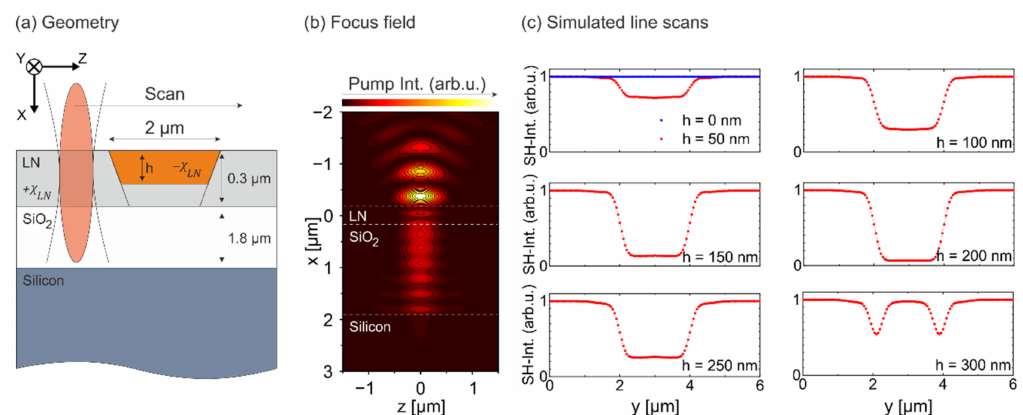
Figure 6. SHG simulations for x-cut TFLN with NA = 0.8 and λ 0 = 800 nm. ( a ) Sample geometry and simulation layout. ( b ) Focus field simulation for all sample layers. ( c ) Simulated SHG intensities for different poling depths of inverted domains in increments of 50 nm domain depth. Only a completely inverted domain allows imaging with a clean DW contrast.